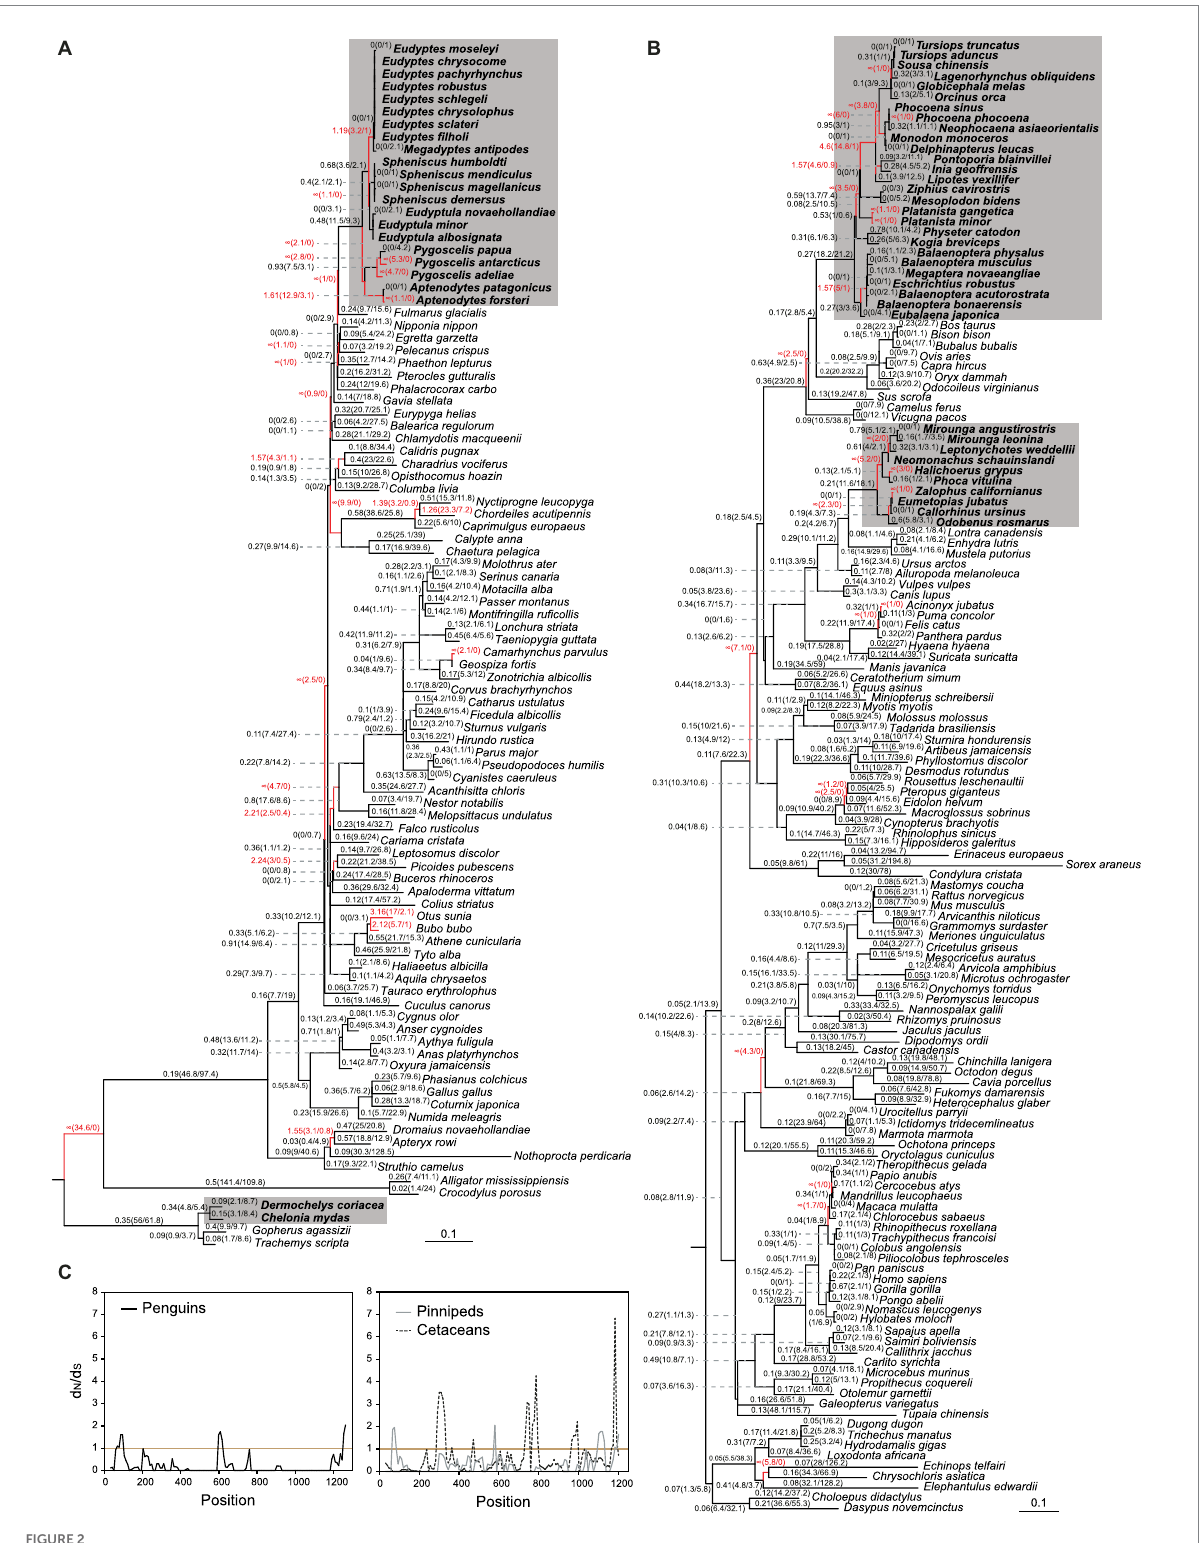
FIGURE 2 Analysis of selection pressure acting upon SAG in amniotes. (A) Selective pressures of SAG in birds and relatives (Sauria), with the deep-diving penguins and sea turtles having a gray background. ω values are shown on branches across the species tree, with the numbers of nonsynonymous and synonymous substitution listed in parentheses. Lineages having ω values greater than one are highlighted in red. (B) ω values for SAG in mammals. Deep-diving pinniped and cetacean species are shown in gray backgrounds. Branches with ω > 1 are shown in red. (C) Sliding window analysis of SAG sequences from the penguin, pinniped or cetacean